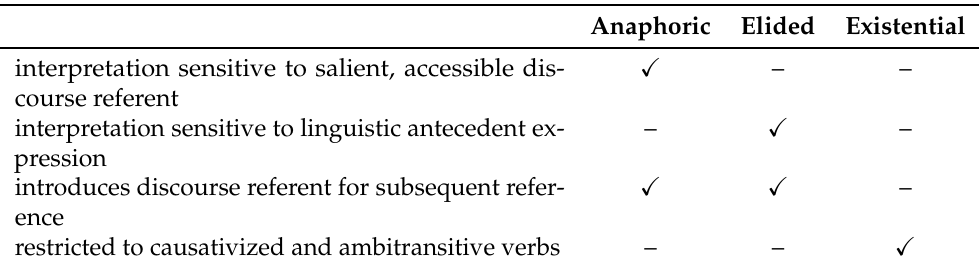
Table 3. Formal distinctions between anaphoric, elided, and existential interpretations of implicit arguments in Paraguayan